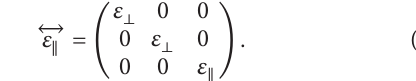
= 𝜀 ⊥ ), (c) intermediate state ( eff = 𝜀 ‖ ). eff